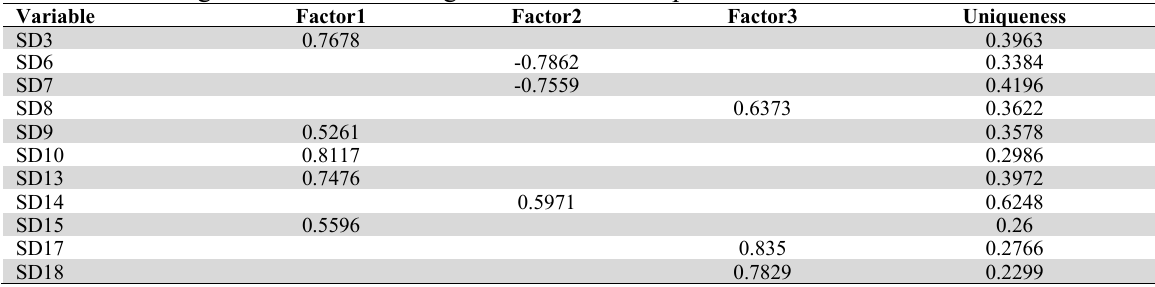
The factor loading of elements affecting sustainable development